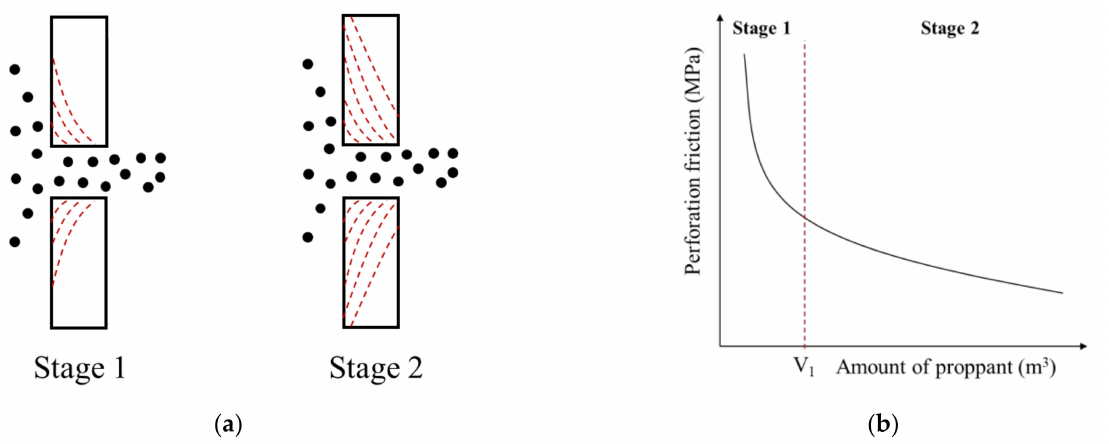
Figure 12. Mechanism of perforation erosion (( a ) two stages during proppant erosion; ( b ) perforation friction curves vs. amount of